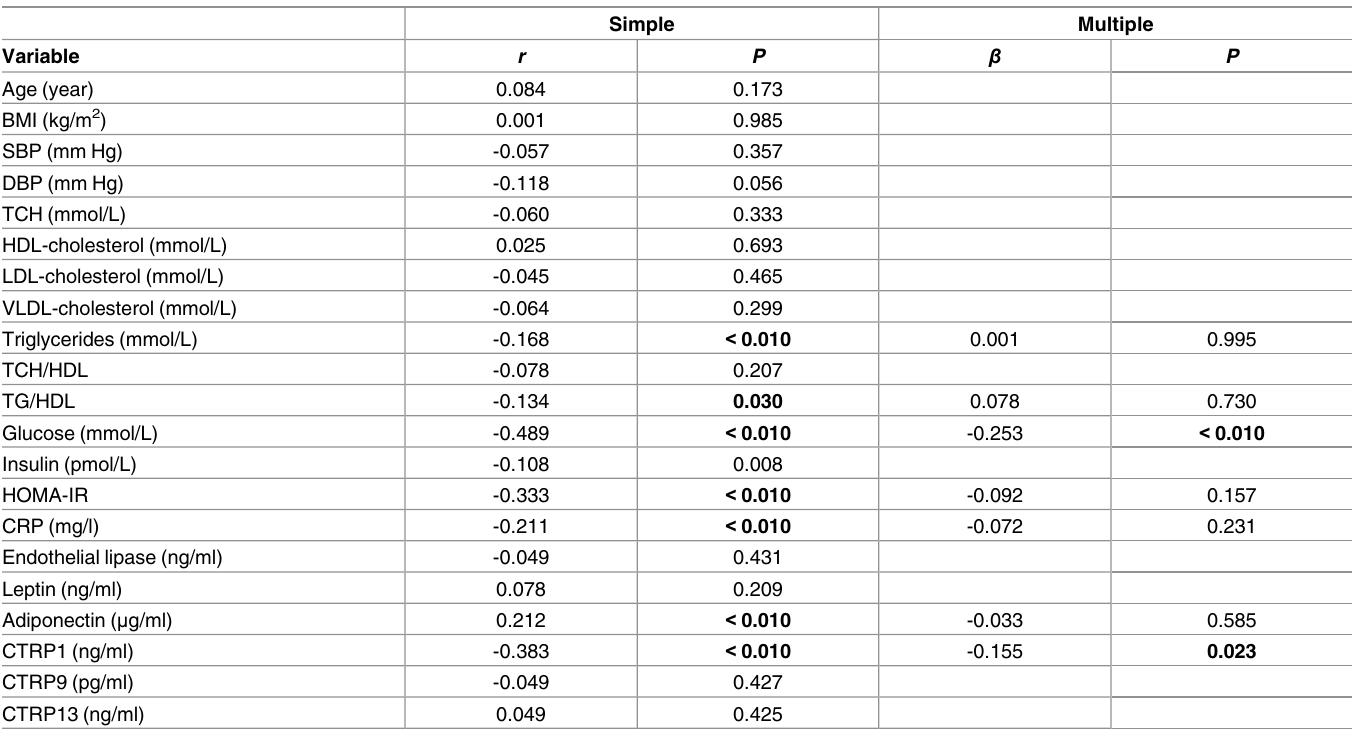
Table 5. Linear regression analysis of variables associated with CTRP12 ( n = 262).